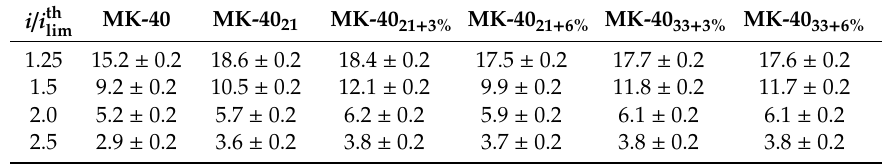
for the studied lim